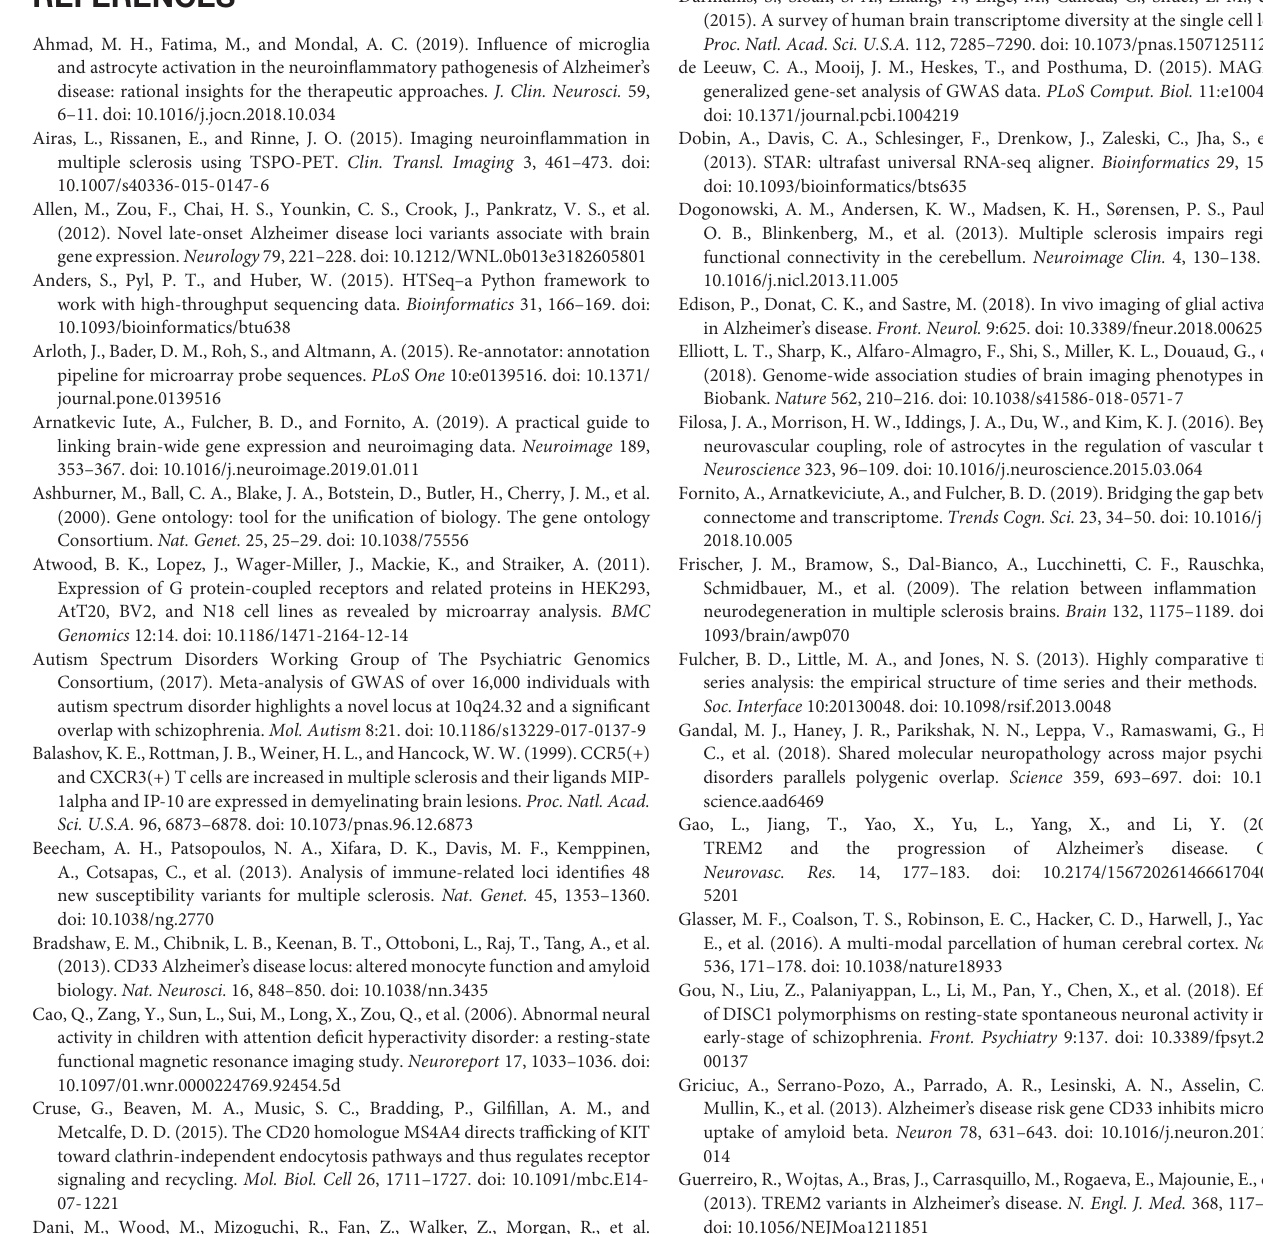
Psychiatric Research Consortium; MDD, major depressive disorder; MEGASTROKE, International Stroke Genetics Consortium; MS, multiple Sclerosis; PD, Parkinson’s disease; PGC, Psychiatric Genomics Consortium; Pc , Bonferroni-corrected P values; SCZ, schizophrenia. Supplementary Table 8 | The MAGMA gene level analysis results in the microglial module for AD and MS. The significant genes common to both discovery and replication GWAS datasets are labeled with bold font. AD, Alzheimer’s disease; IGAP, International Genomics of Alzheimer’s Project; IMSGC, International